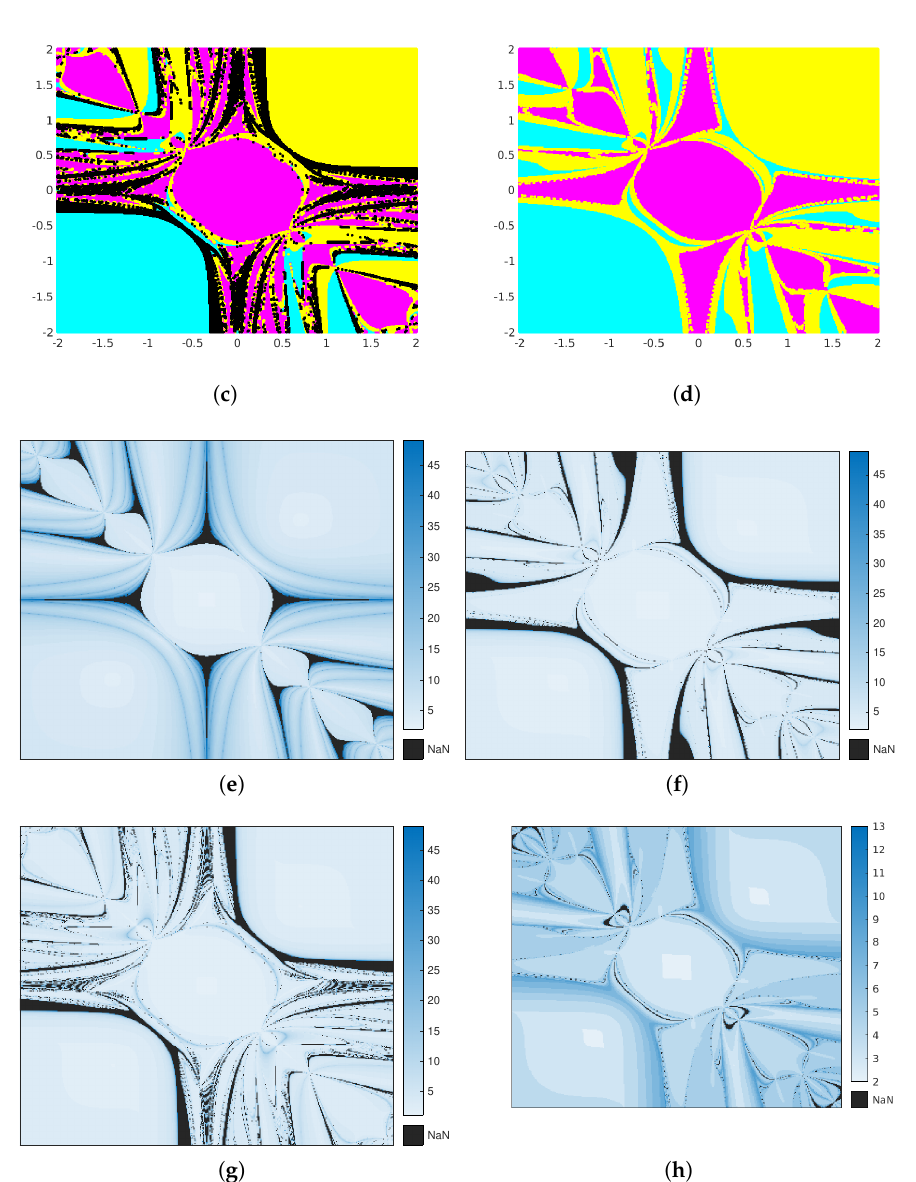
Figure 1. Basins of attraction for the Example 5. ( a ) Newton’s Method; ( b ) Weerakoon Method; ( c ) Extension 1 (3); ( d ) Extension 2 (4). Heat maps for ( e ) Newton’s Method; ( f ) Weerakoon Method; ( g ) Extension 1 (3); ( h ) Extension 2